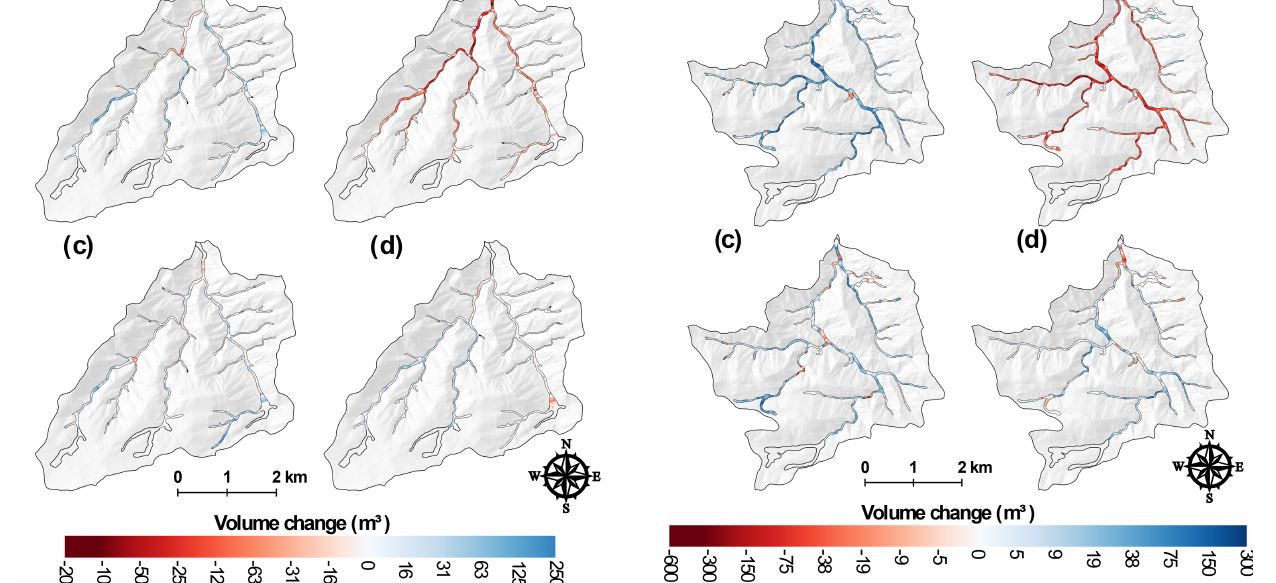
Figure 6. Net volume differences for each valley bottom segment in Skin Gulch for (a) T1 (201210–201307), (b) T2 (201307–201310), (c) T3 (201310–201409), and (d) T4 (201409–201506). Calcu- lated volumes are not reported for the transparent segments in the headwaters and segments furthest downstream (outlined by heavier black lines) due to unrealistically wide valley widths, repeat exca- vations, or the ground surface not being reliably determined.